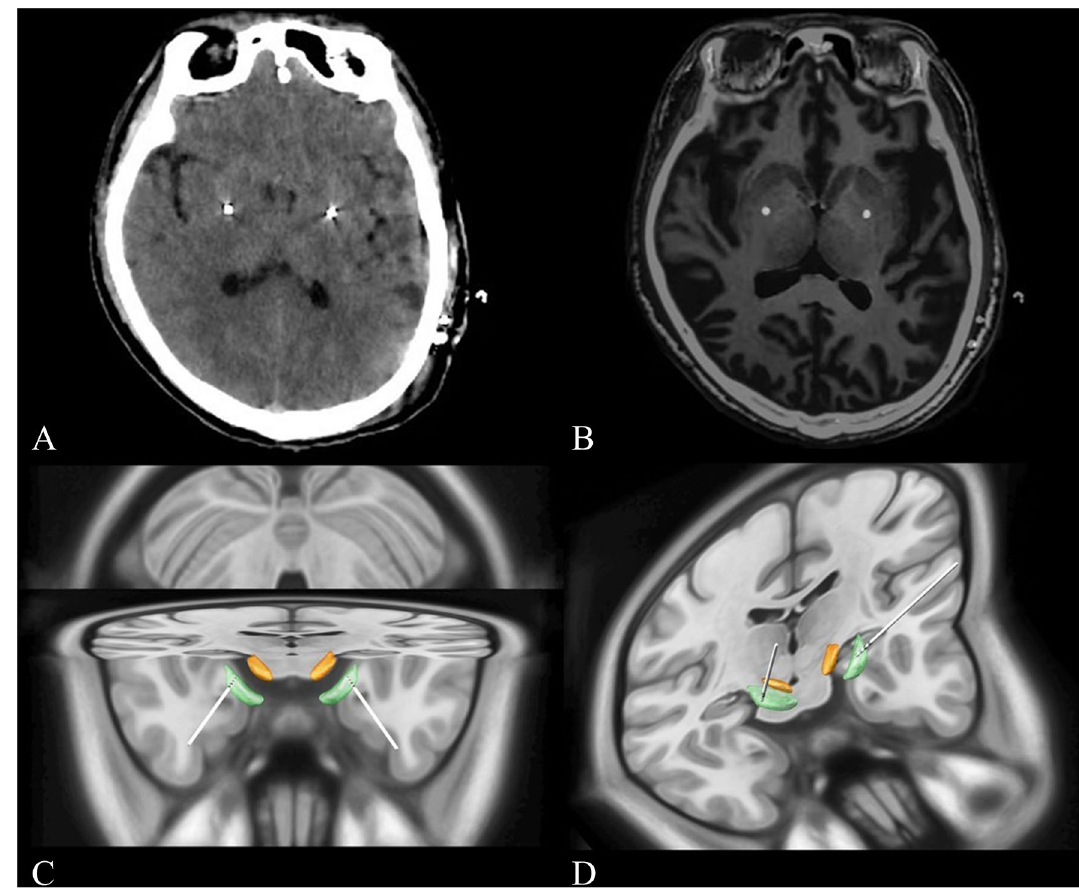
Figure 2. ( A ) Postoperative CT showing the location of electrodes in the internal globus pallidus (GPi); ( B ) Preoperative MR and postoperative CT fusion showing the location of electrodes in the GPi; ( C ) and ( D ) Schematic diagram of 3D reconstruction of the implanted electrodes in the